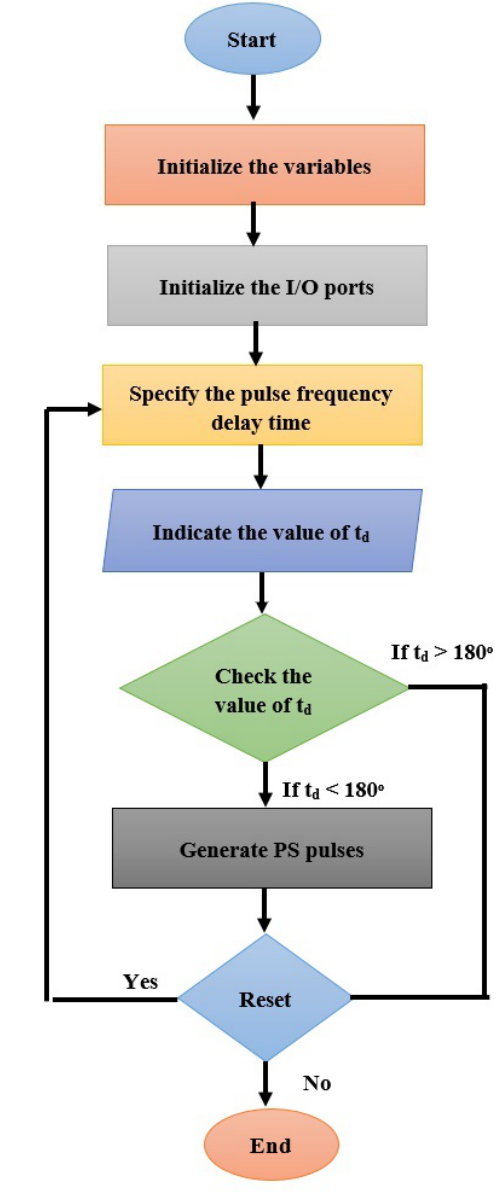
Figure 18. Flow chart of PS control